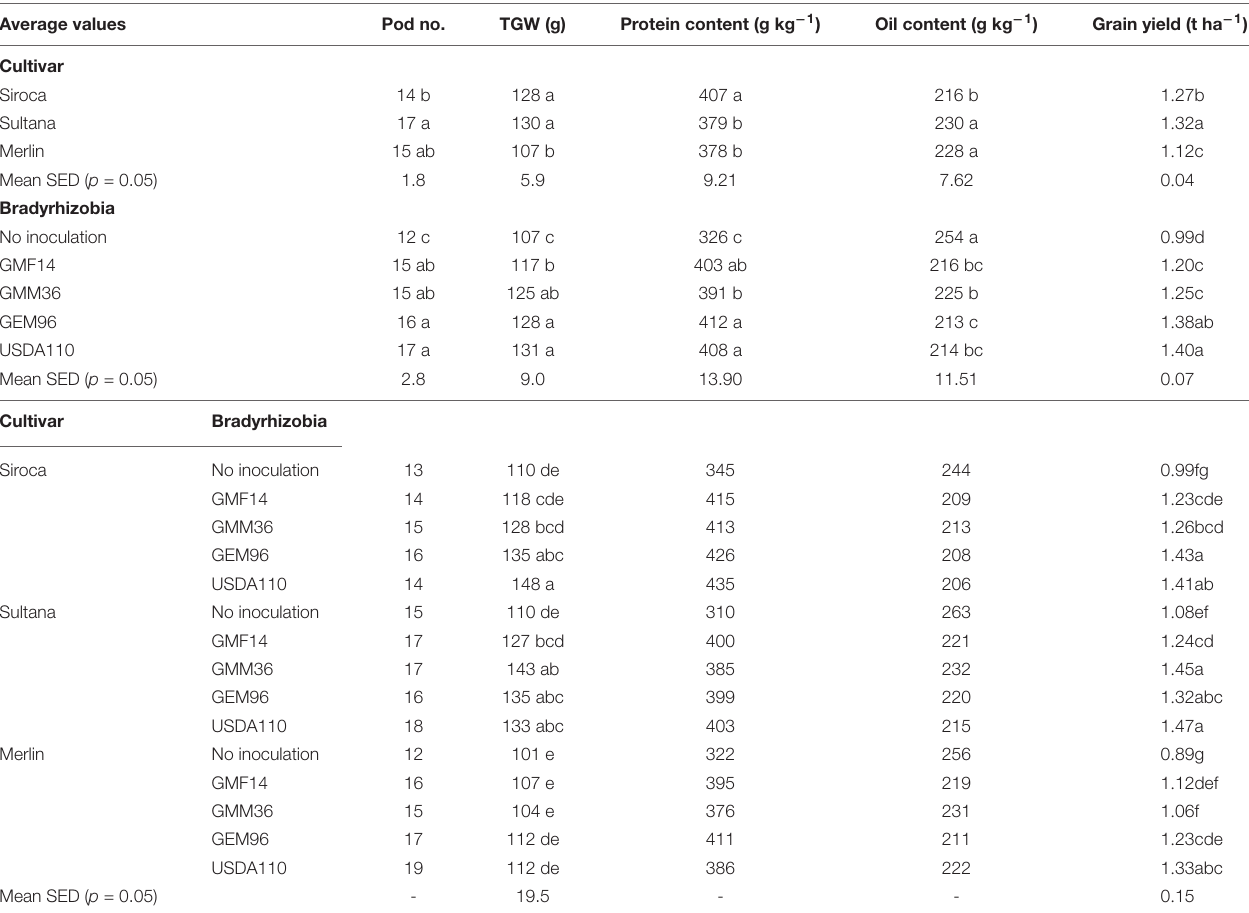
TABLE 5 | Effects of different Bradyrhizobium strains inoculated to three soybean cultivars and their interaction on grain yield, pod number, protein yield, and thousand-grain weight under field conditions. Average values Pod no. TGW (g) Protein content (g kg − 1 ) Oil content (g kg − 1 ) Grain yield (t ha − 1 ) Cultivar Siroca